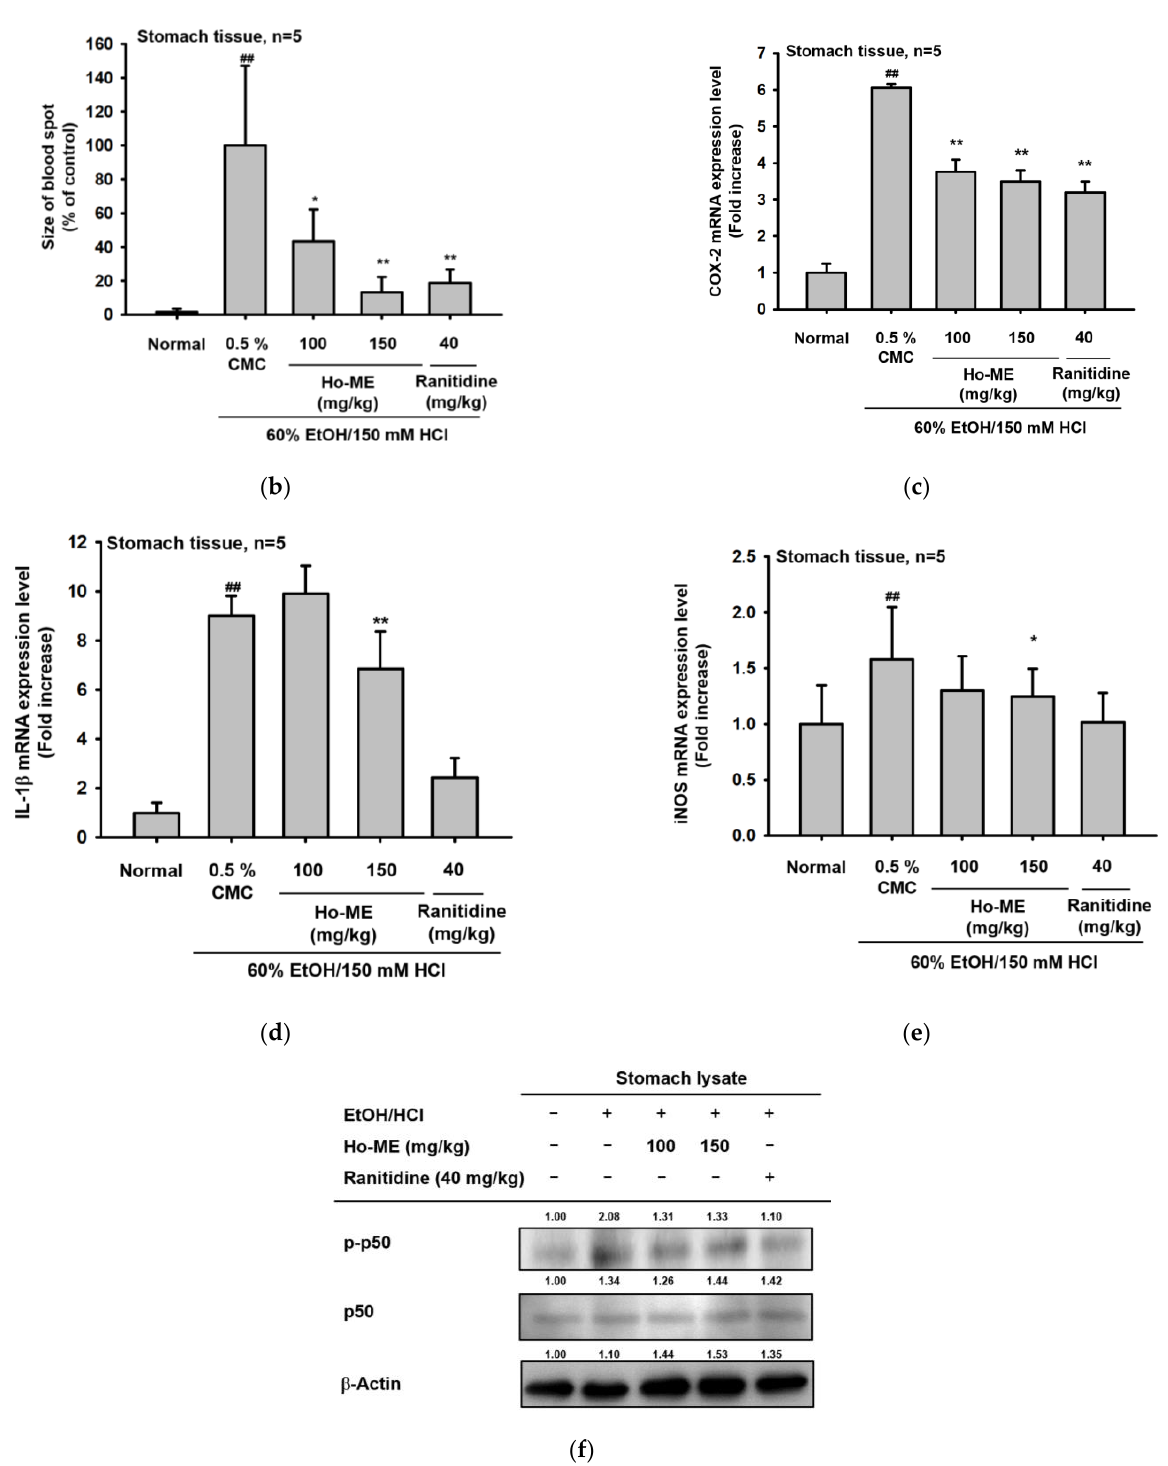
Figure 4. The gastroprotective ability of Ho-ME in an in vivo gastritis model. ( a ) Photographs of the stomach at 1 h after administration of mixed HCl and EtOH. ( b ) Blood spot areas were quantified with ImageJ software. ( c – e ) Inflammation-related mRNA expression levels were analyzed in the gastric tissue. ( f ) After Ho-ME treatment, downregulation of transcription factor phosphorylation was detected. The numbers above the images are the relative intensity values measured with ImageJ software. All data are presented as mean ± standard deviation (SD) calculated from the indicated number of independent samples. ##: p < 0.01 compared to the non-stimulated group and *: p < 0.05 and **: p < 0.01 compared to the control group.